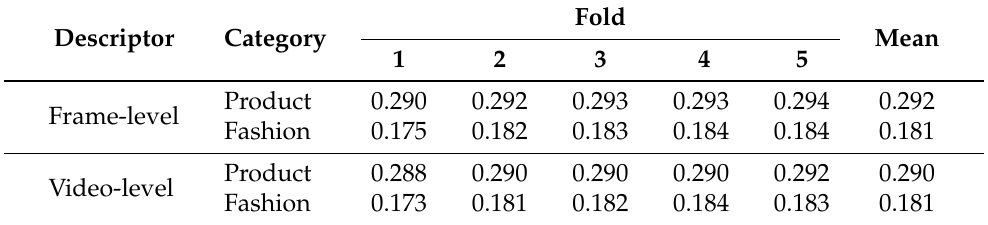
Table 2. Performance comparison between frame-level feature (TCA f ) and video-level feature (TCA c ).